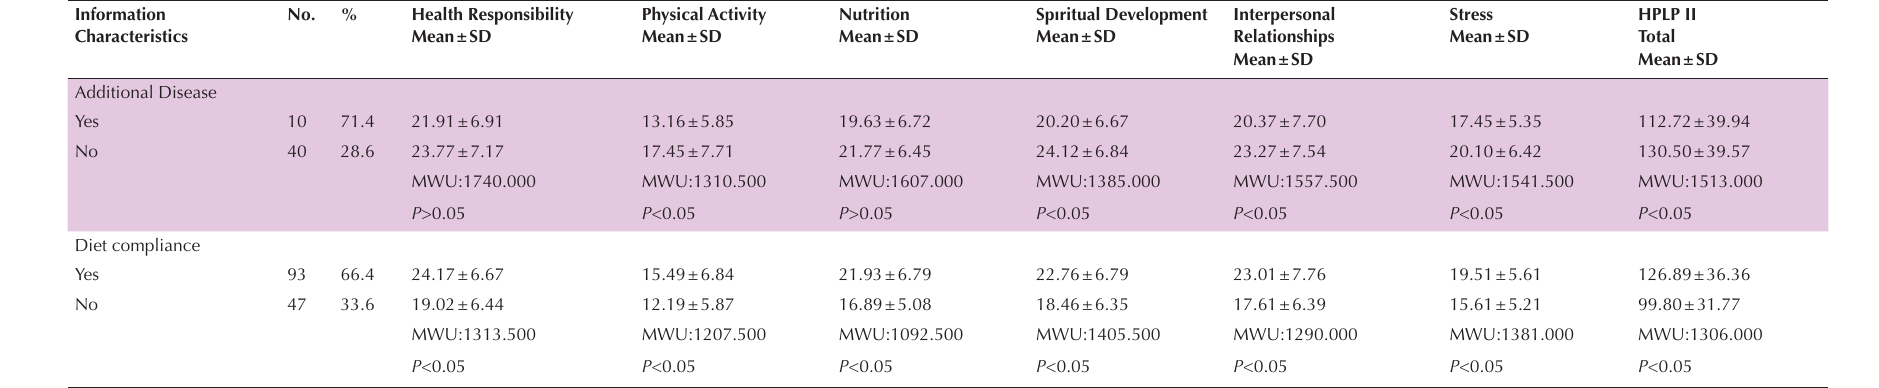
Table 5. The distribution of the mean averages of the patients in the SCS II according to the diet compliance and other chronic disease Information